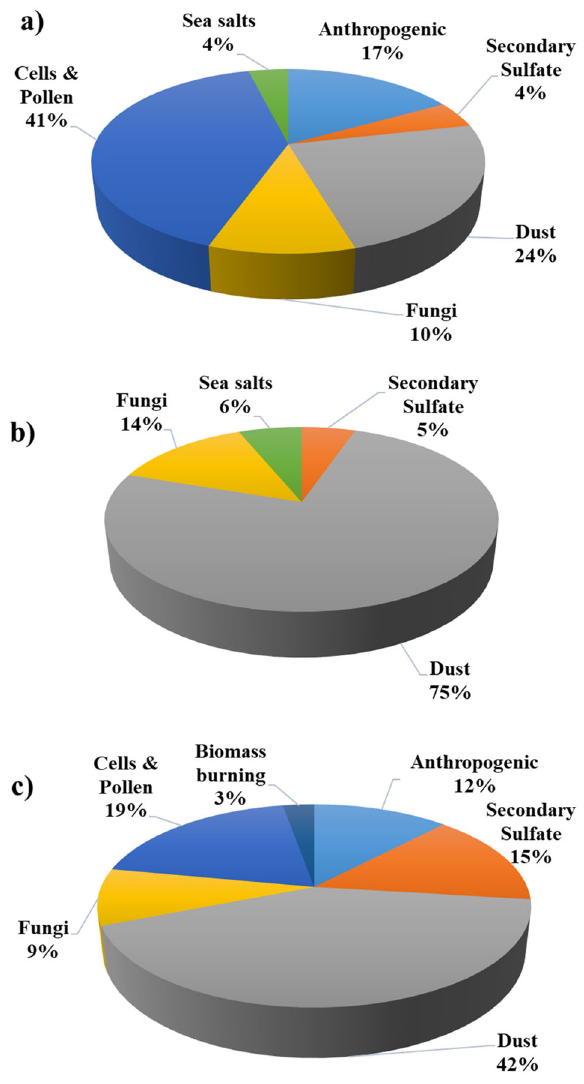
Fig. 2 Percentage contribution of the sources to the P species. Source contribution of ( a ) org-P fraction, ( b ) Condensed P (CP), ( c ) Phosphate ions in atmospheric particles in the eastern Mediterra- nean area by using the approach of positive matrix factorization (PMF). CP are the condensed inorganic phosphates (pyro-. meta-, and other